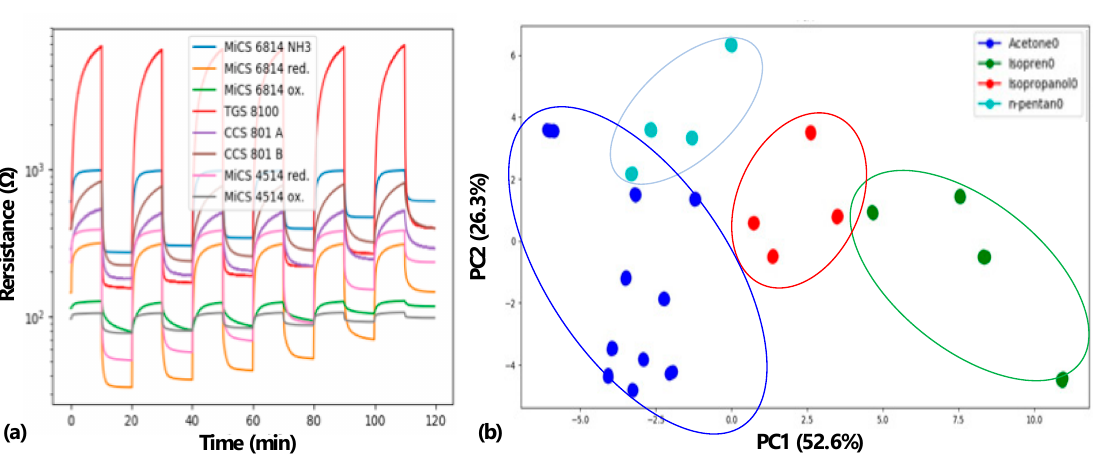
Figure 2. Raw signals from analog MOX sensors in one of the three compartments responding to several concentrations (3–18 ppm) of ethanol at 22% of RH and 45 °C ( a ), and PCA scores plot of 25 measurements from first experiment ( b